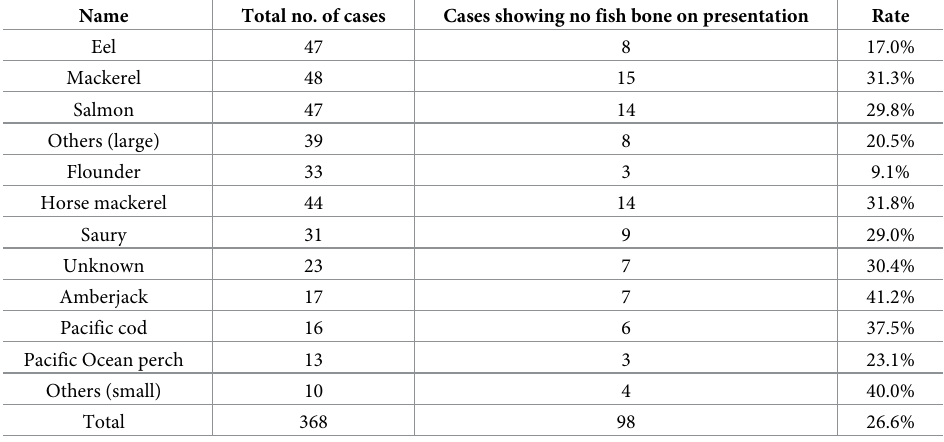
The number of cases without detectable fish bones was significantly lower in the flounder group (flounder vs the others, p =